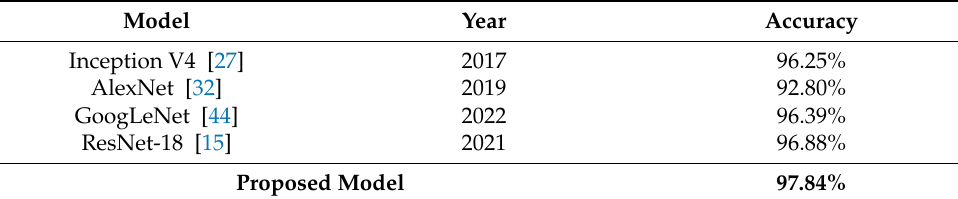
Figure 13. Average Class Accuracy of the four Models. Table 6. Comparison of the proposed model with existing